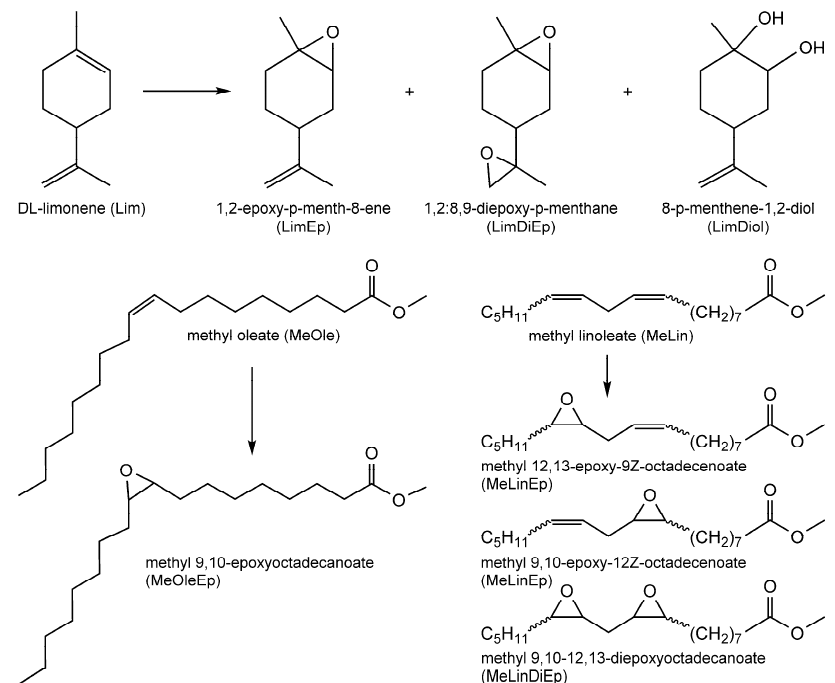
Table 2. Catalytic results for 2 and [MoO 3 (biim)] in the epoxidation of bio ‐ derived olefins.